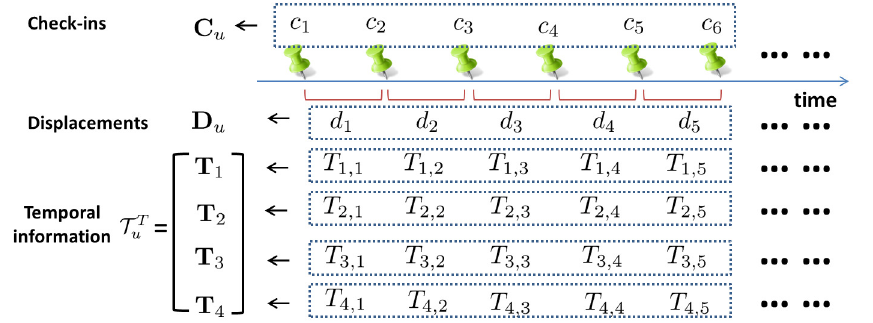
Figure 3. An example of user u ’s check-in records C u , vector of displacements D u and the corresponding 4-dimension temporal information T u